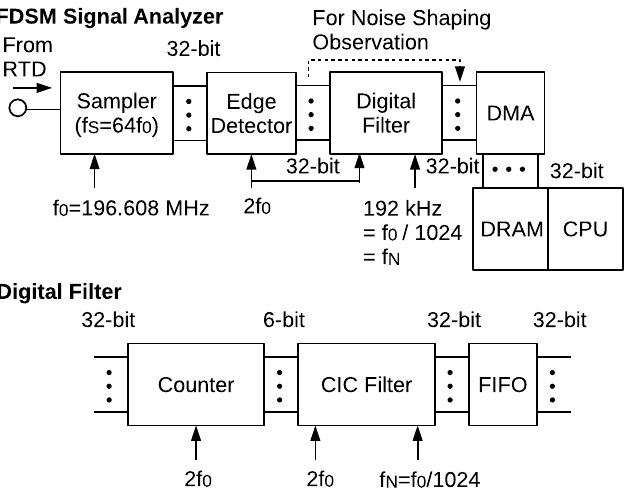
Figure 14. Block diagram of the signal-analyzer circuit on an FPGA. The lower illustration details the digital filter, which eliminates the high-frequency noise components and converts the PDM signal to a 32-bit parallel signal at the Nyquist rate.